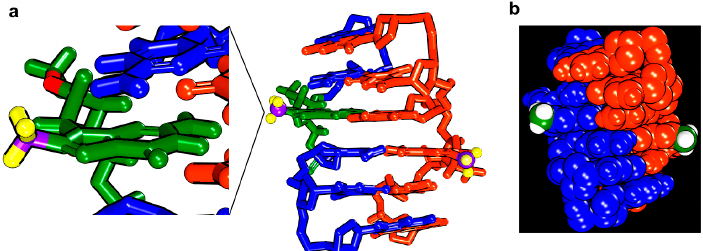
Figure 5. The model for r(CGC[m 8 Gm]CG) 2 Z-RNA structure. ( a ) m 8 Gm is expanded in green with the C8-methyl group, hydrogen and carbon of methyl group are coloured in yellow and purple. ( b ) Hydrogen and carbon of methyl group are coloured in green and white. C8-methyl groups were located outside of